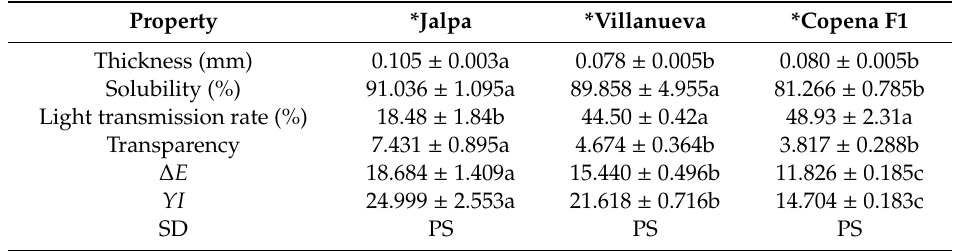
Table 1. Physicochemical properties of the edible films based on the mucilage of three cultivars of Opuntia ficus-indica . Property *Jalpa *Villanueva *Copena